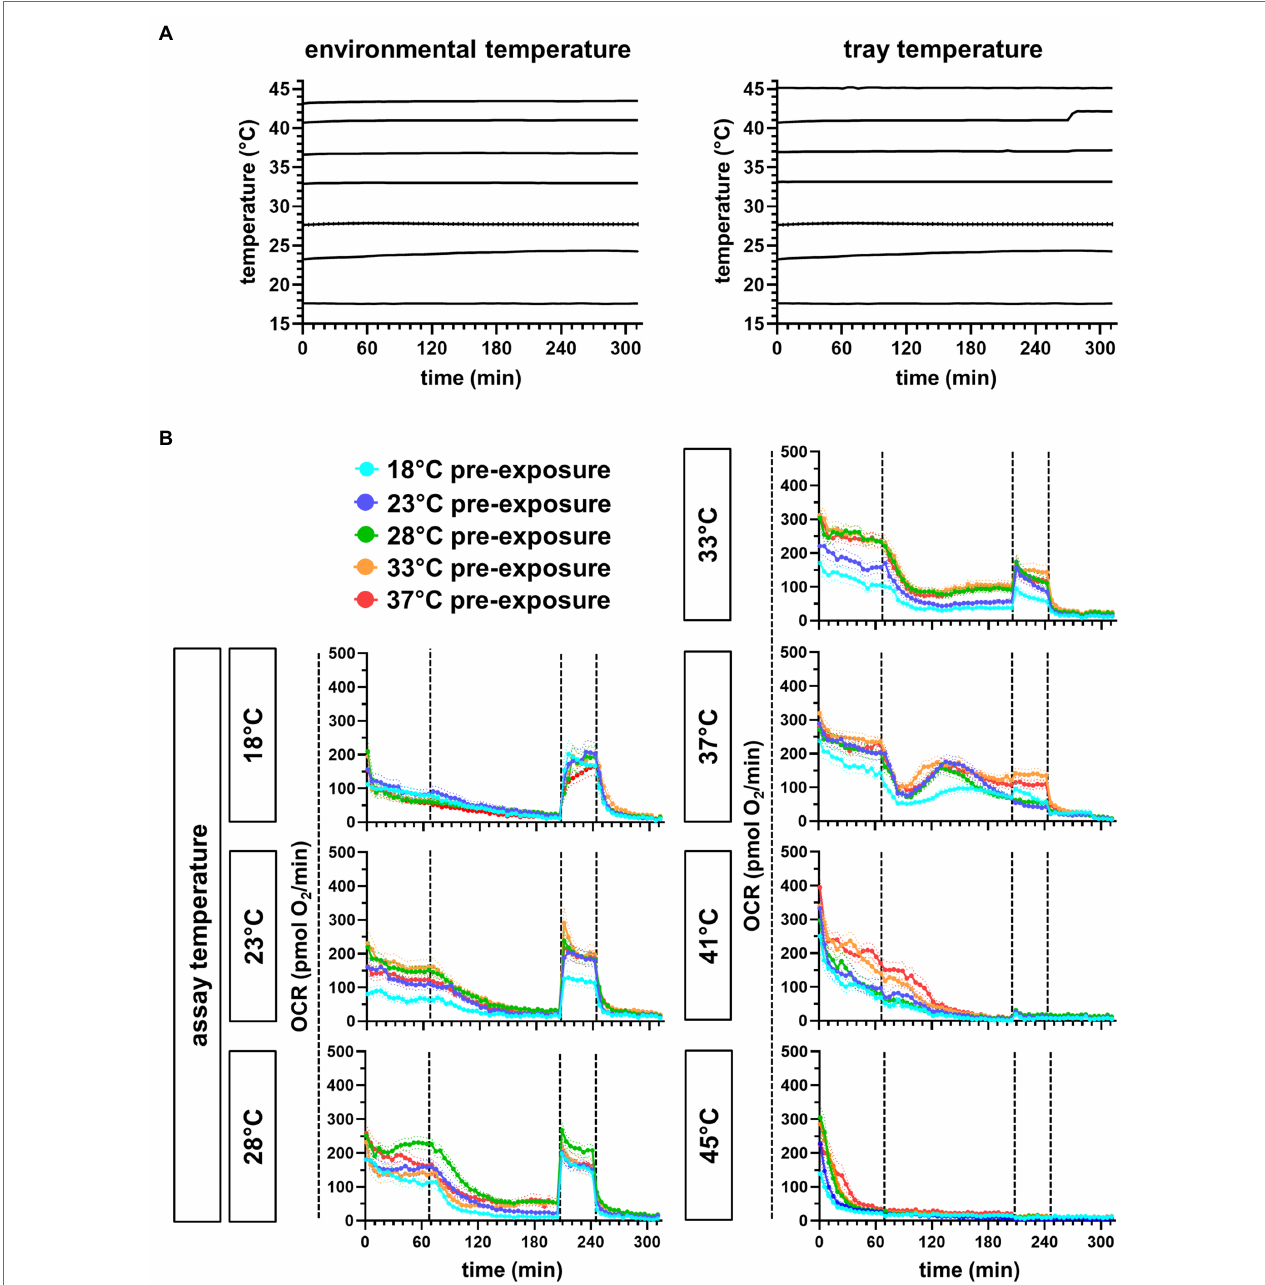
FIGURE 4 | Continuous temperature registration of the XF96 Seahorse and respiration traces of differentially exposed embryos at different assay temperatures. (A) Instrument temperatures of the interior (environmental temperature) and of the tray, where the plate wells are located. (B) Pre-exposure temperatures are depicted in different trace colors. The mean trace is represented by n individual measurements ( n = 16 for 18 ° C, 41 ° C, and 45 ° C; n = 32 for 23 ° C, 28 ° C, 33 ° C, and 37 ° C, measured on two experimental